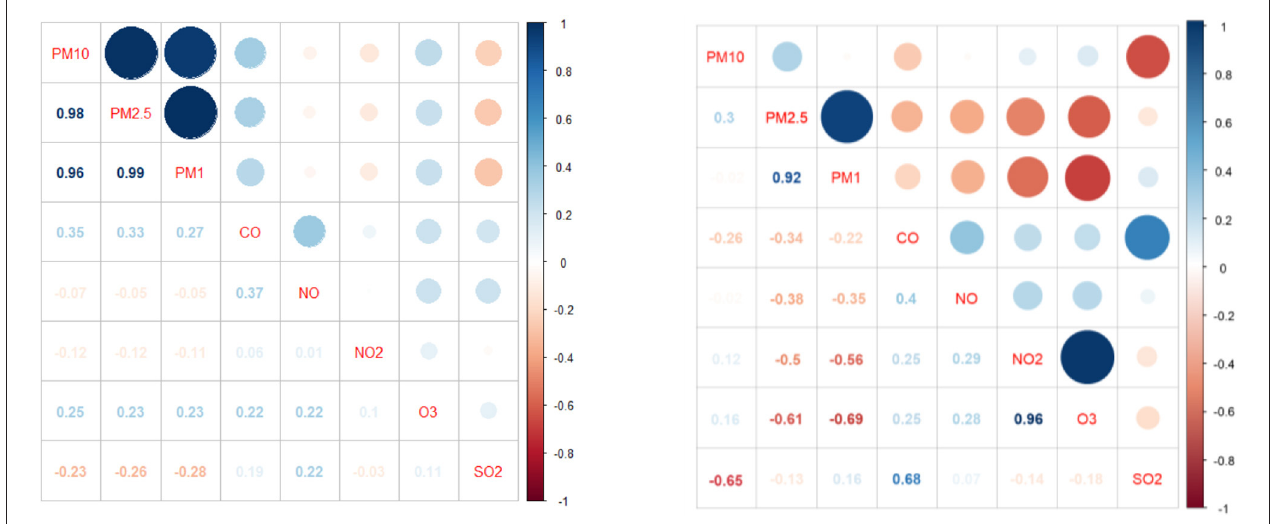
FIGURE 5 | Distribution of the correlation coefficients of 8 contaminations in the library ( Left ) and canteen ( Right